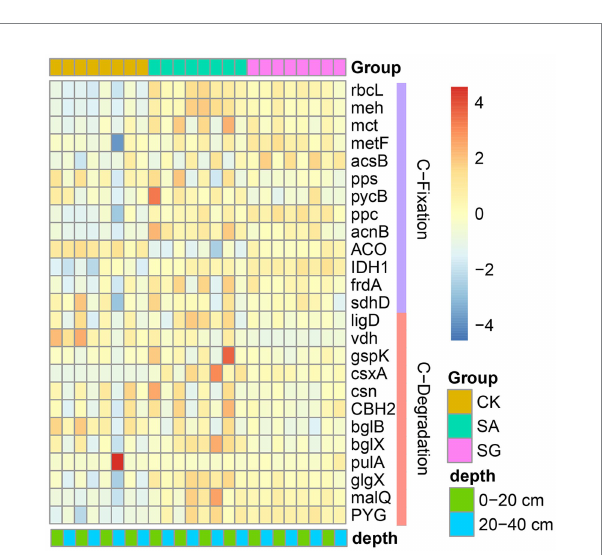
FIGURE 5 Effects of ecological restoration on the relative abundance of functional genes involved in C-cycling according to